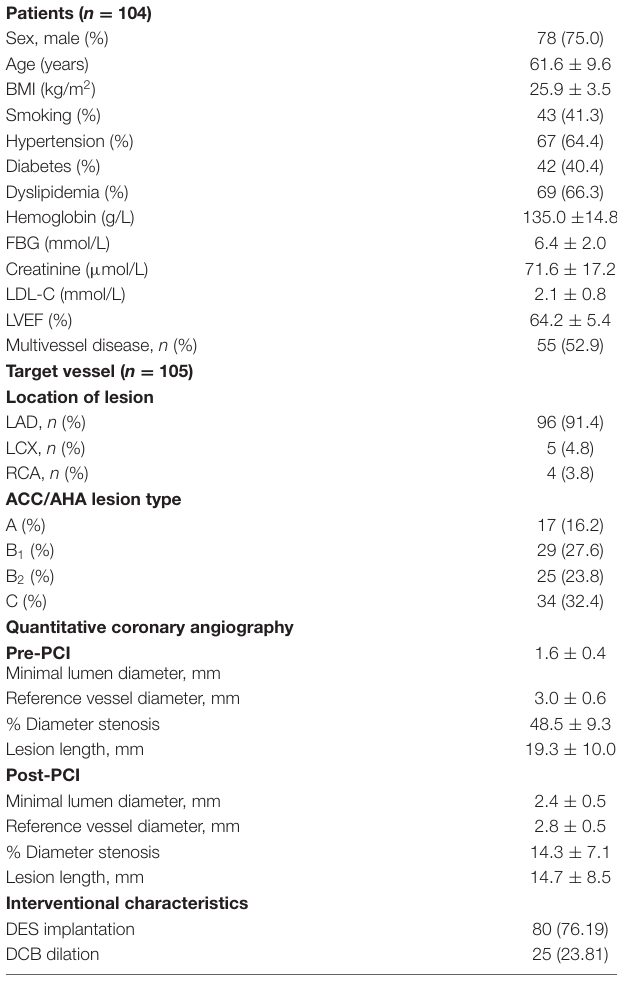
FFR, fractional flow reserve; caFFR, coronary angiography-derived FFR; BMI, body mass index; FBG, fasting blood glucose; LDL-C, low-density lipoprotein cholesterol; LVEF, Left ventricular ejection fraction; LAD, left anterior descending artery; RCA, right coronary artery; LCX, left circumflex artery; ACC, American College of Cardiology; AHA, American Heart Association; PCI, percutaneous coronary intervention; DES, drug-eluting stent; DCB, drug-coated